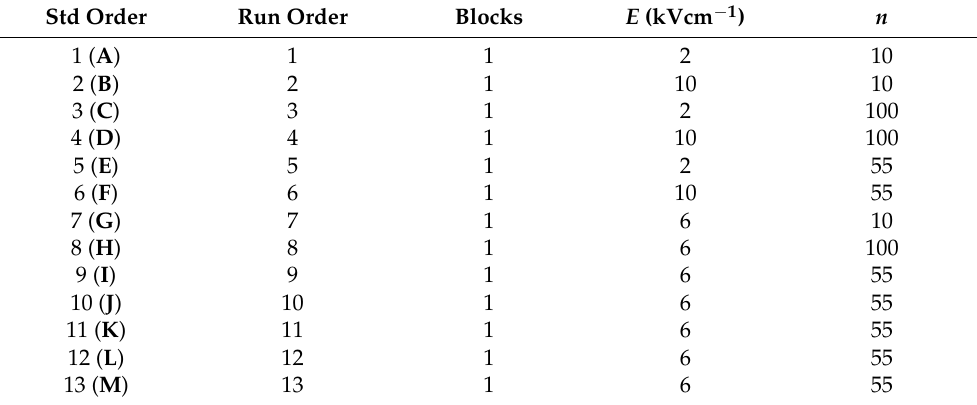
Table 1. Experimental design for the application of low-intensity pulsed electric field processing. Std